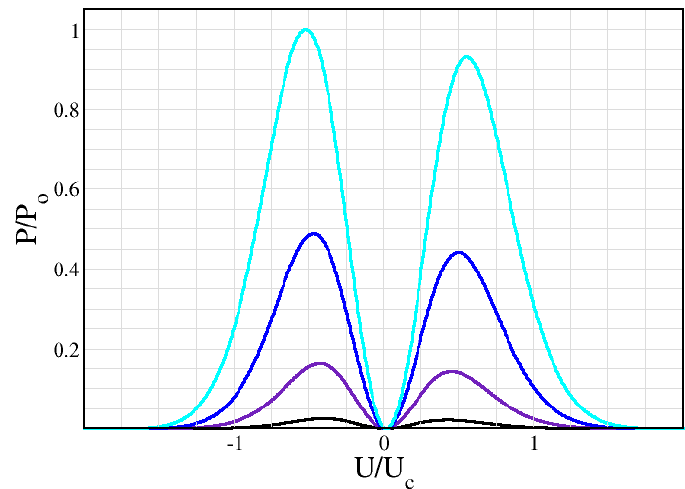
Figure 3. Second Harmonic power output for different values of the power control parameter, with an input frequency ν = 120 GHz. From bottom to top, α = 10, 16.7, 23.3 and 30, corresponding to black, violet, blue and cyan curves. The current flow asymmetry for all curves is δ = 1.1. U c is the same as in Figure 1 and P 0 is the maximum for α = 30.